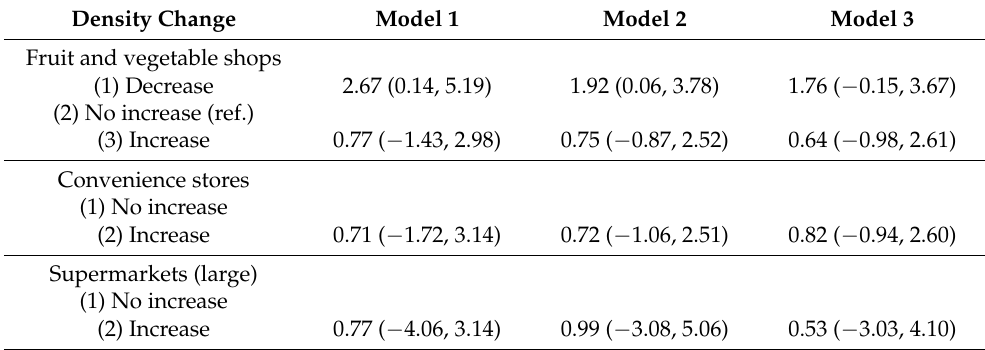
Table 3. Multilevel linear regression models of neighborhood-level density * changes of food store type and systolic blood pressure (SBP) measures for total sample ( n = 2798).